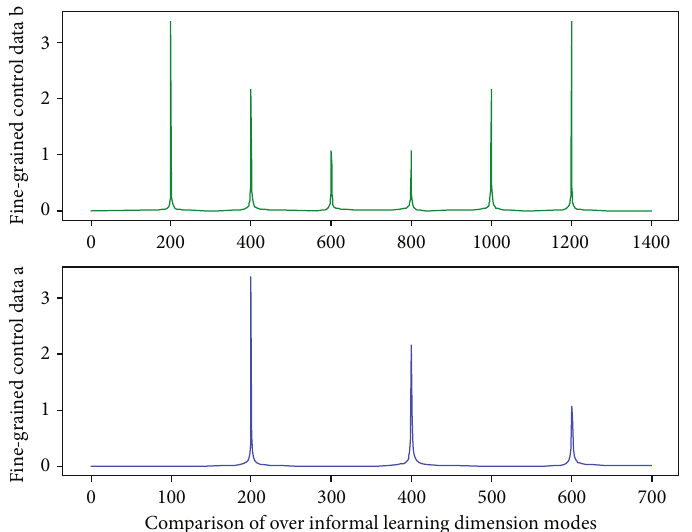
Figure 9: Fine control of informal learning dimension.